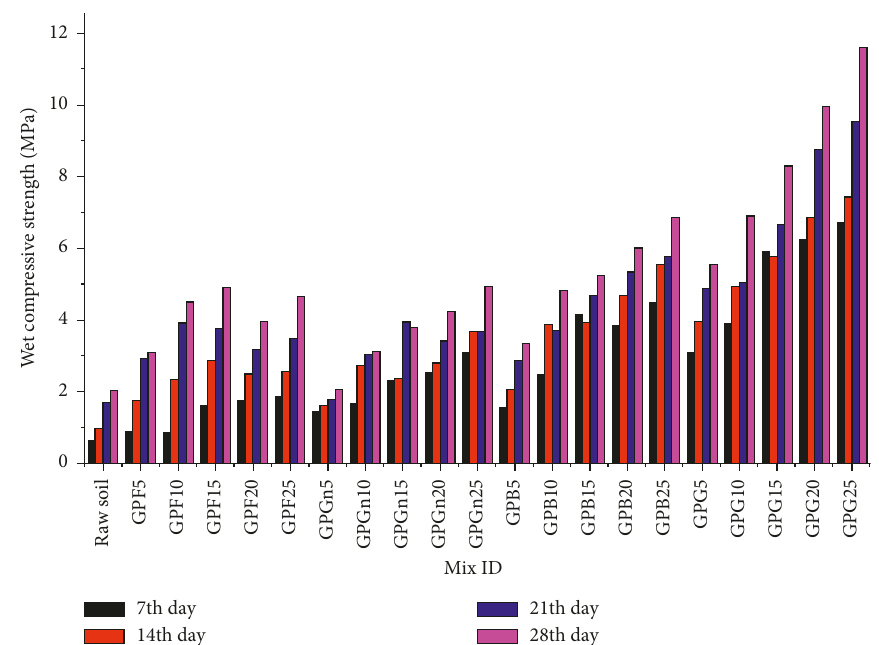
Figure 3: Wet compressive strength for stabilized geopolymer mud